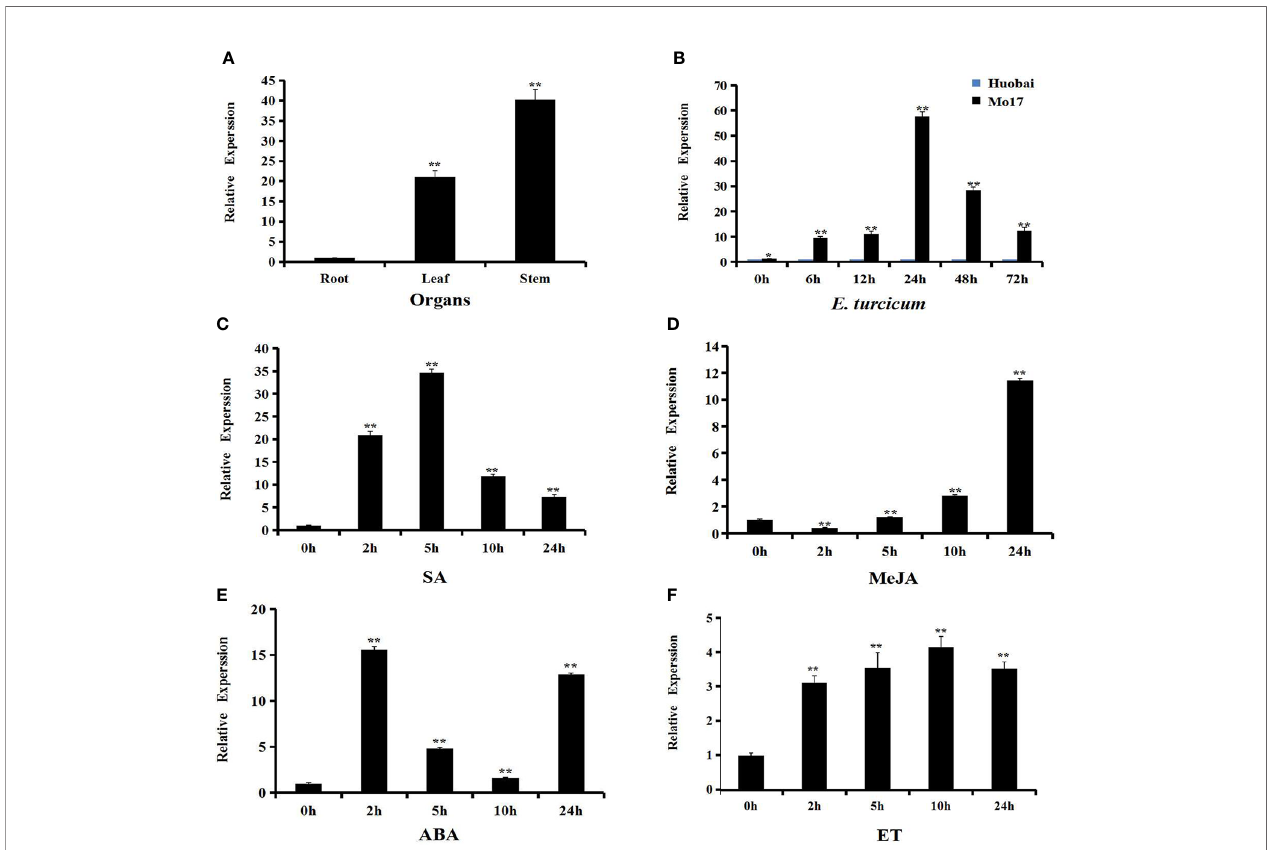
FIGURE 3 | Expression pro fi les of ZmERF105 in maize. (A) Expression analysis of ZmERF105 in different organs. (B) Relative expression levels of ZmERF105 in Mo17 (resistant inbred line) and Huobai (susceptible inbred line) plants infection with E. turcicum . The samples were collected at 0, 6, 12, 24, 48, and 72 h after E. turcicum infection. The relative expression levels were compared with susceptible inbred line Huobai at same points. (C – F) Expression analysis of ZmERF105 under hormone treatments, including 0.5mM SA, 0.1mM MeJA, 0.1mM ABA or ET. The relative expression levels were calculated by the 2 - DD Ct method with the maize housekeeping gene ZmTub (GRMZM2G066191) as an internal control. The experiment was performed using three biological and technical replicates each, and analyzed using Student' t -tests (*P < 0.05, **P < 0.01). Bars indicate standard error of the mean